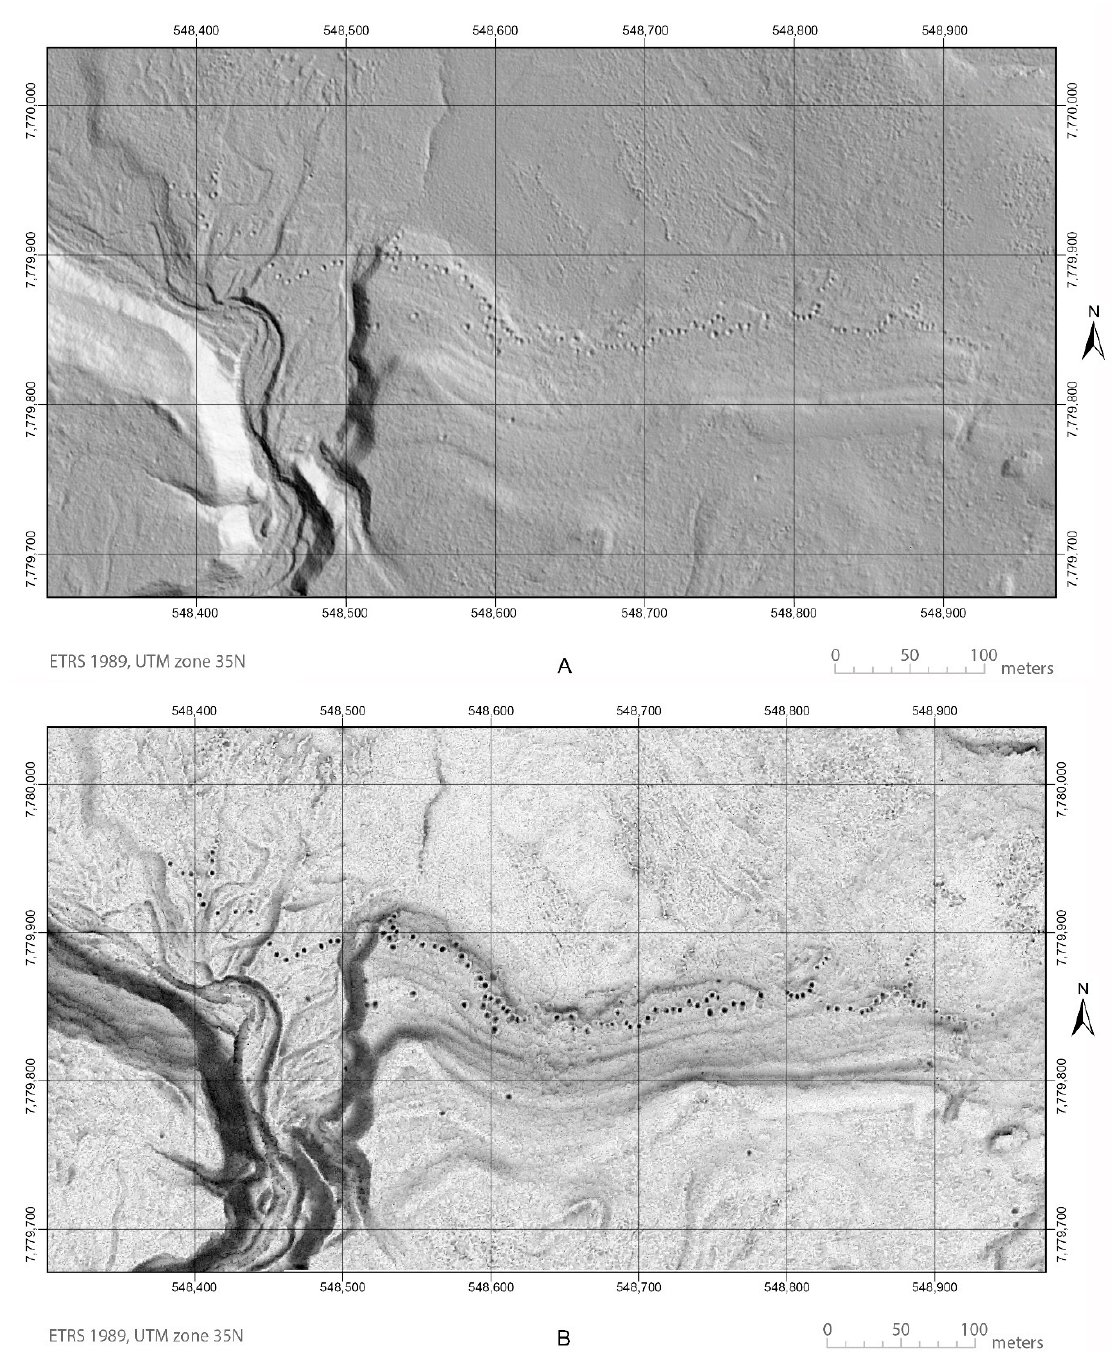
Figure 10. A section of a large system of hunting pits (pitfalls) at Gollevarre in Tana municipality, northern Norway (upper image, A ). The pits are particularly visible at in the lower image ( B ) where they stand out as black spots located like pearls on a string with an eastern–western course. The total system consists of more than 800 aligned pits reaching several kilometers across the landscape [106]. The upper image is a digital terrain model (DTM) and the same section is visualized in the lower image by the use of the sky-view factor visualization technique [107]. (Illustration: Ole Risbøl).